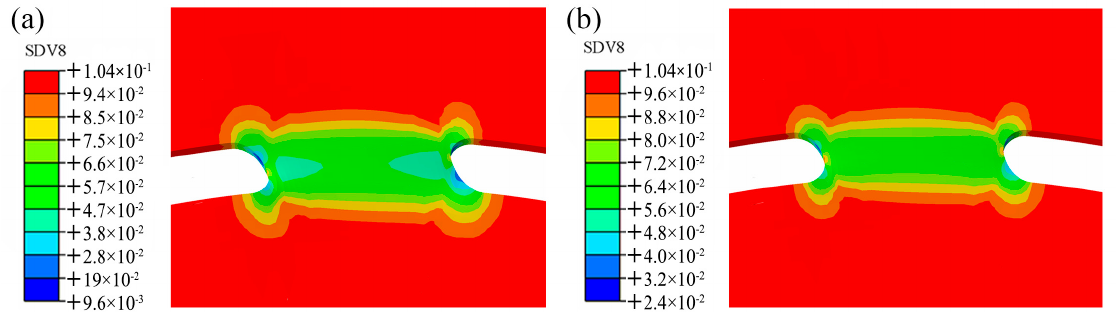
Figure 18. Distribution of retained austenite at different torsion stages in the critical area of the twin bridge torsion shear specimen: ( a ) ε eq = 0.07; ( b ) ε eq = 0.12.